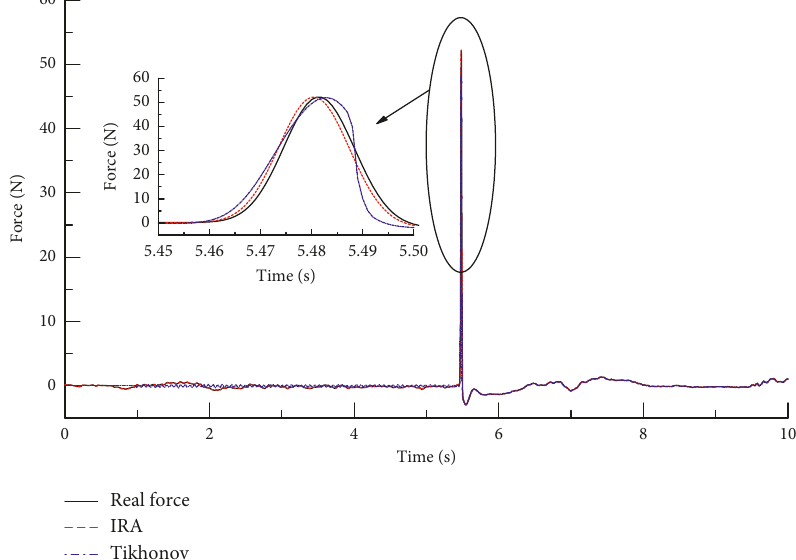
Figure 12: Identified results of the impact load.